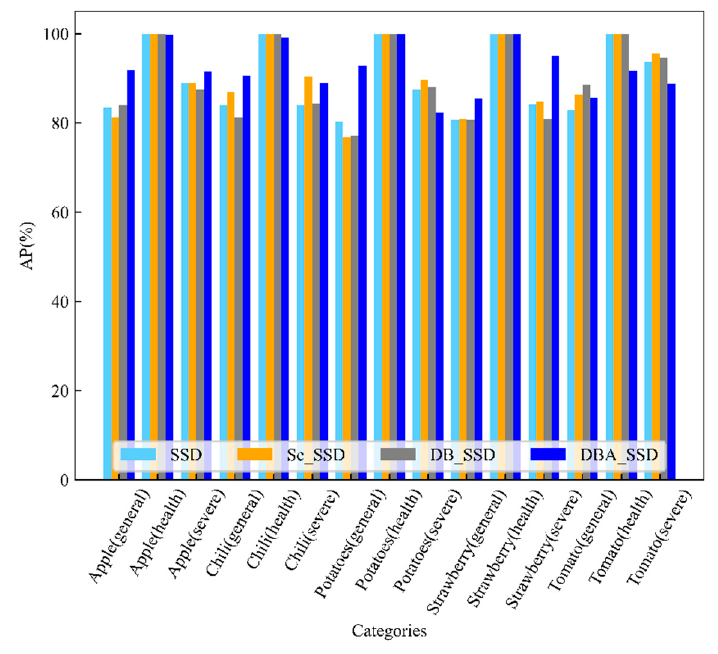
Figure 11. AP diagram of SSD and its improved algorithm for the detection of different kinds of diseases.